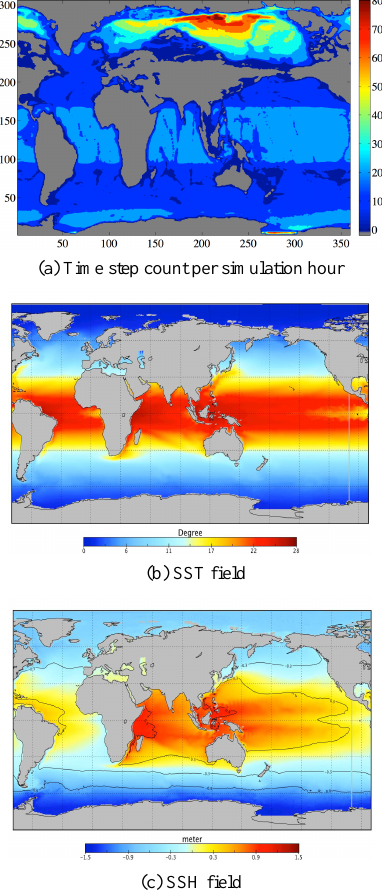
Figure 10. Model evaluation of sample grids with SCSC mapping.